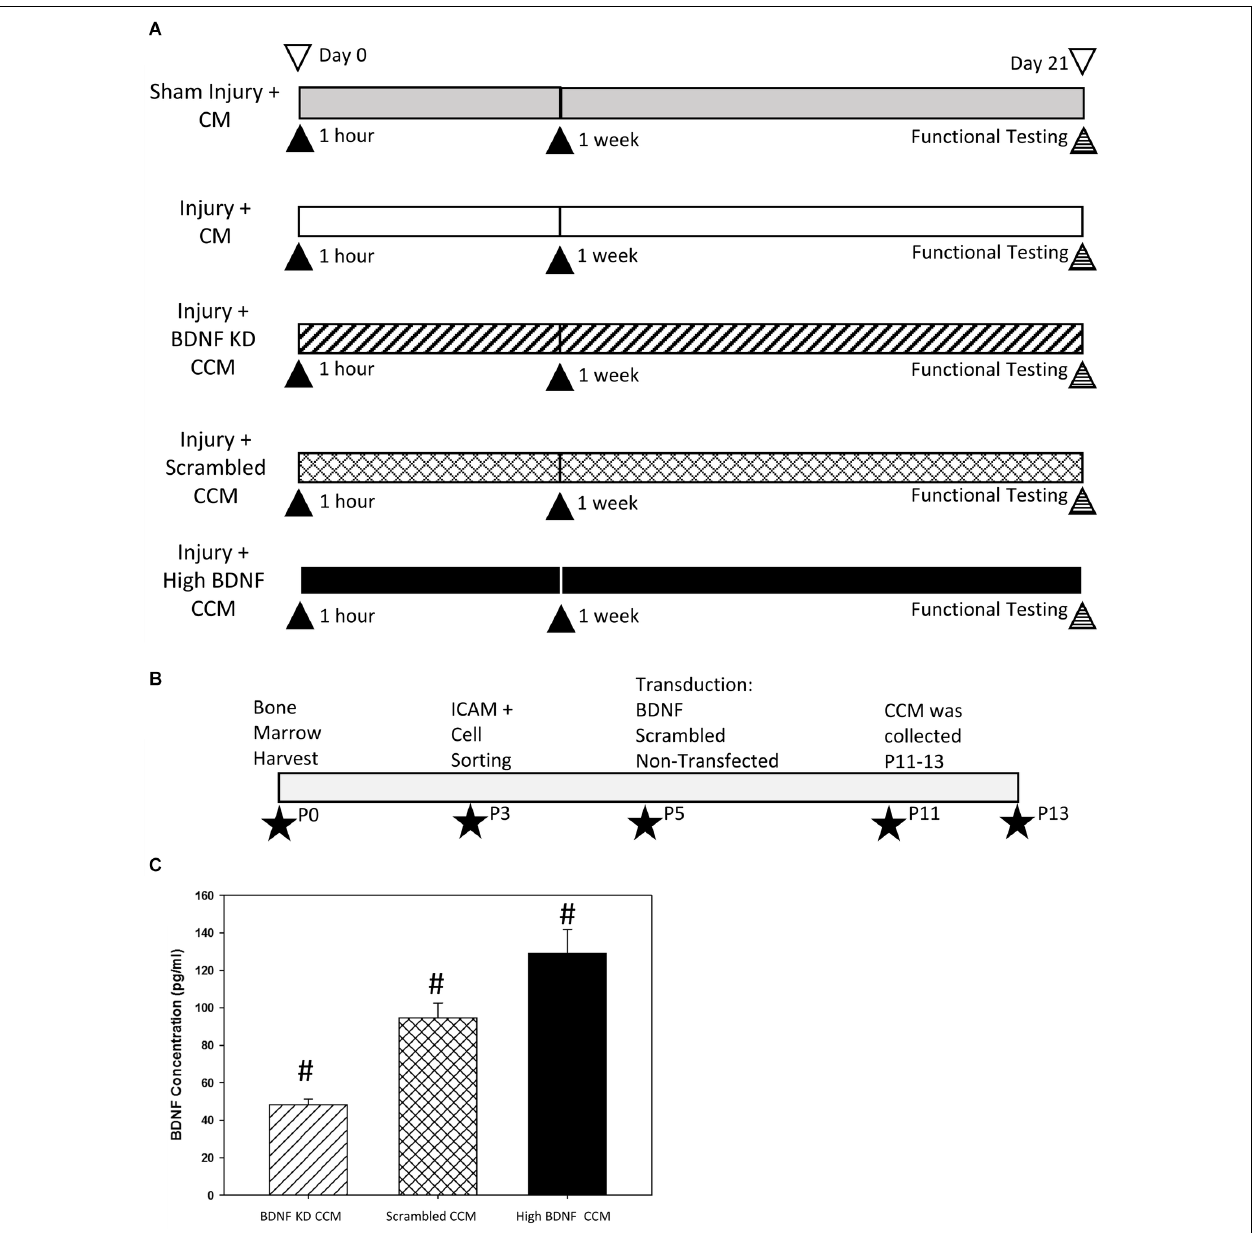
FIGURE 1 | Experimental design diagrams and BDNF knockdown validation. Experimental design (A) indicating the five experimental groups: Sham Injury + Control Media (CM), Injury (Pudendal Nerve Crush + Vaginal Distension) + CM, Injury + Brain-Derived Neurotrophic Factor Knockdown (BDNF KD) Concentrated Conditioned Media (CCM), Injury + Scrambled CCM, or Injury + High BDNF CCM. (cid:78) Indicates an intraperitoneal injection of treatment. Experimental timeline of mesenchymal stem cell (MSC) purification, transductions, and CCM production (B) . (cid:70) Indicates the passage at which the procedure was performed. Validation of BDNF concentration (C) . CCM BDNF concentration. Bars are mean ± standard error of the means from 3 to 5 samples per group. ANOVA followed by a Student-Newman-Keuls post-hoc test was used to indicate significant differences. # Indicates a significant difference compared to the other two